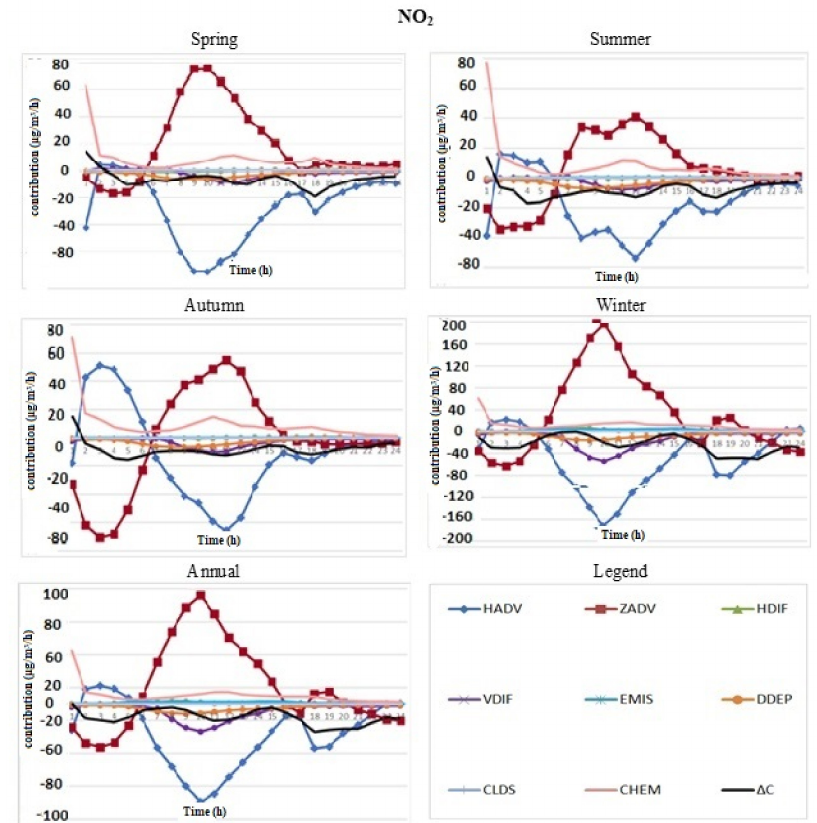
Figure 16. Annual, seasonal and diurnal course of the contribution of the different dynamic and chemical processes of the formation of NO 2 concentrations ( µ g/m 3 /h) averaged for Bistritsa for the period